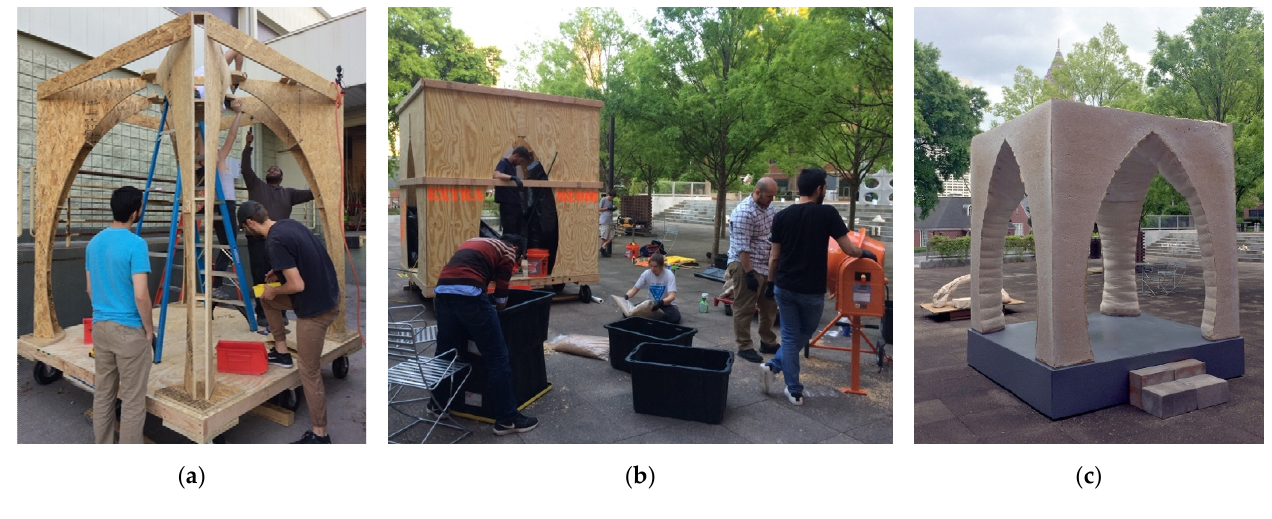
Figure 2. The Monolito Micelio, grown in early 2018 with students at Georgia Institute of Technol- ogy. ( a ) Construction of the wooden internal reinforcing; ( b ) in a manner resembling cast-inplace concrete, mycelilum composite materials were processed on-site with water and nutritional addi- tives and immediately packed into the plywood and geo-textile formwork; ( c ) finished structure, used as a stage and pavilion for a choir performance and exhibited at the School of Architecture. Photos by the author.